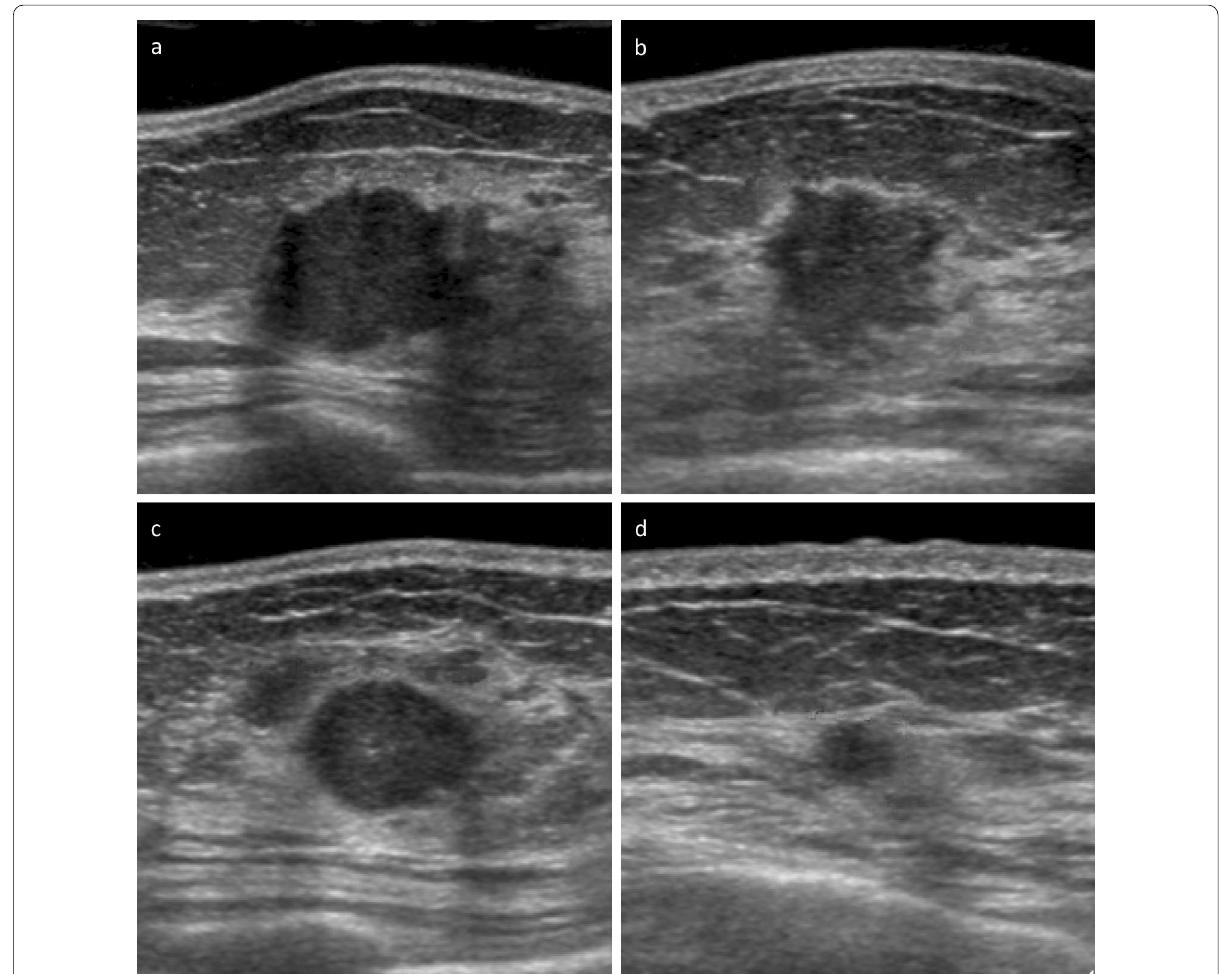
Fig. 3 Ultrasonographical findings of the breast tumors. Multiple low echoic tumors with irregular margins in both breasts were observed. a The breast tumor in the right upper-outer area (1). b The breast tumor in the left lower-inner area (2). c The breast tumor in the left upper-outer area (3). d The breast tumor in the left upper-inner